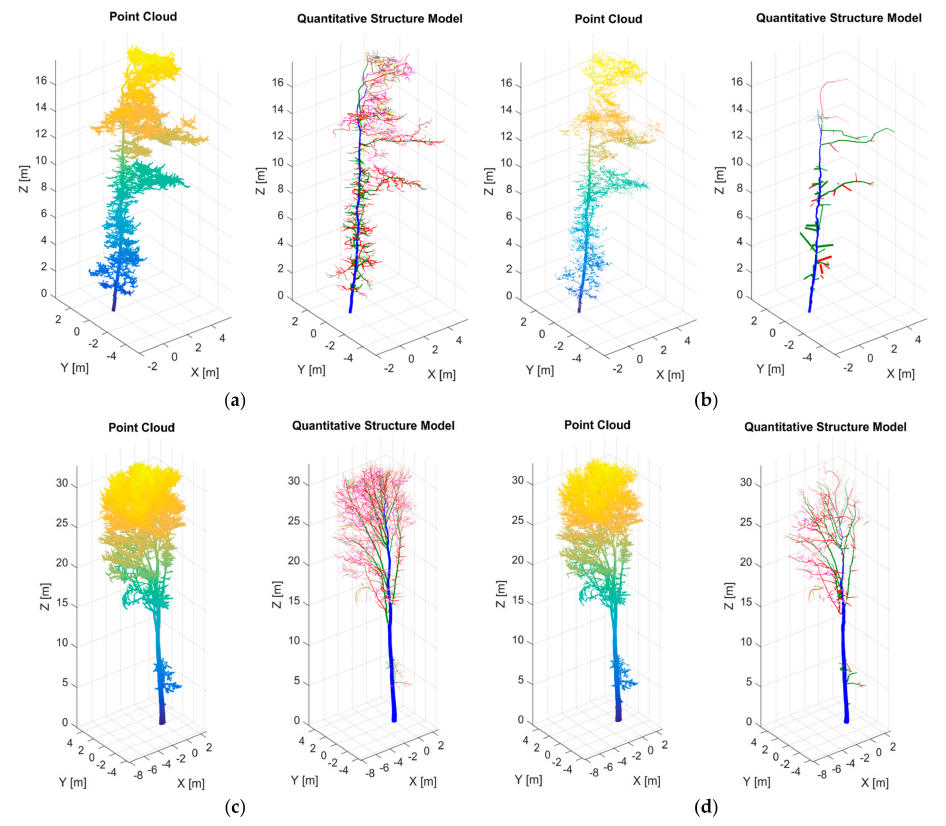
Figure 9. Segmented tree point clouds with the extracted QSM of two trees of the leaf-off datasets of plot 1. Top: Carpinus betulus tree ( a ) TLS; ( b ) MLS; Bottom: Fagus sylvatica tree ( c ) TLS; ( d ) MLS.